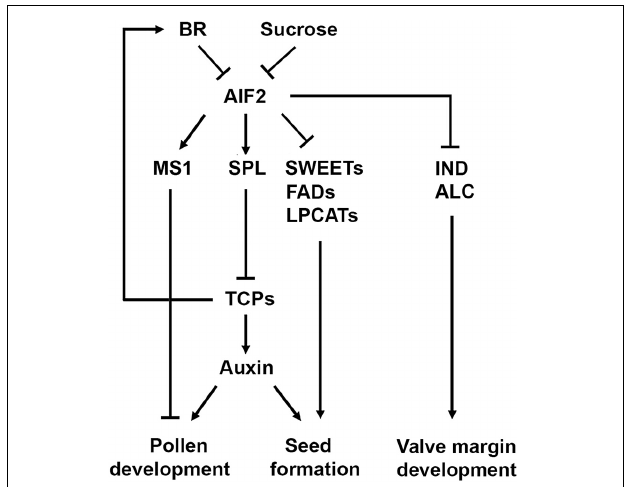
FIGURE 9 | A diagram explaining AIF2-regulated pollen development and seed formation. Stage-independent aberrant expression of pollen-producing genes such as SPL and MS1 together with suppression of sucrose-transporting SWEET s, lipid biosynthesis-regulating FAD s/ LPCAT s, and valve margin-forming IND / ALC in AIF2ox plants may act adversely on pollen microspore development, auxin-regulated seed formation and proper silique development. Sucrose- and BR-induced repression of AIF2 bHLH transcription factor positively controls pollen development and/or seed size and